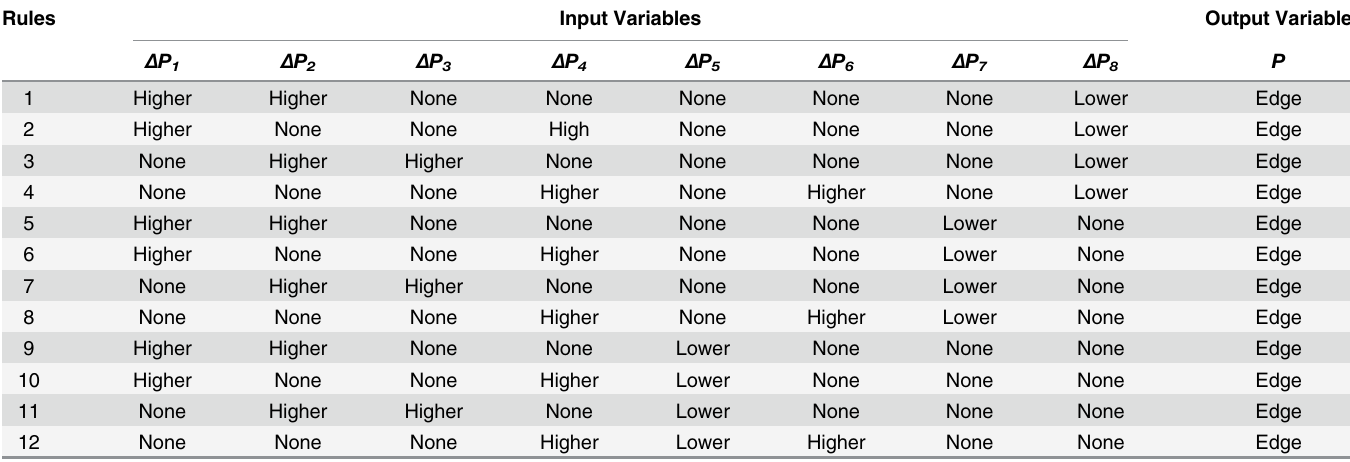
Table 2. Fuzzy knowledge base for the developed edge detection